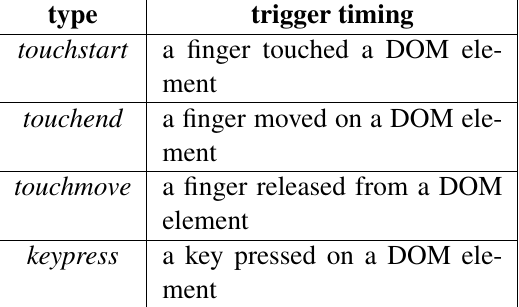
Table 2. The types and trigger timing of DOM events